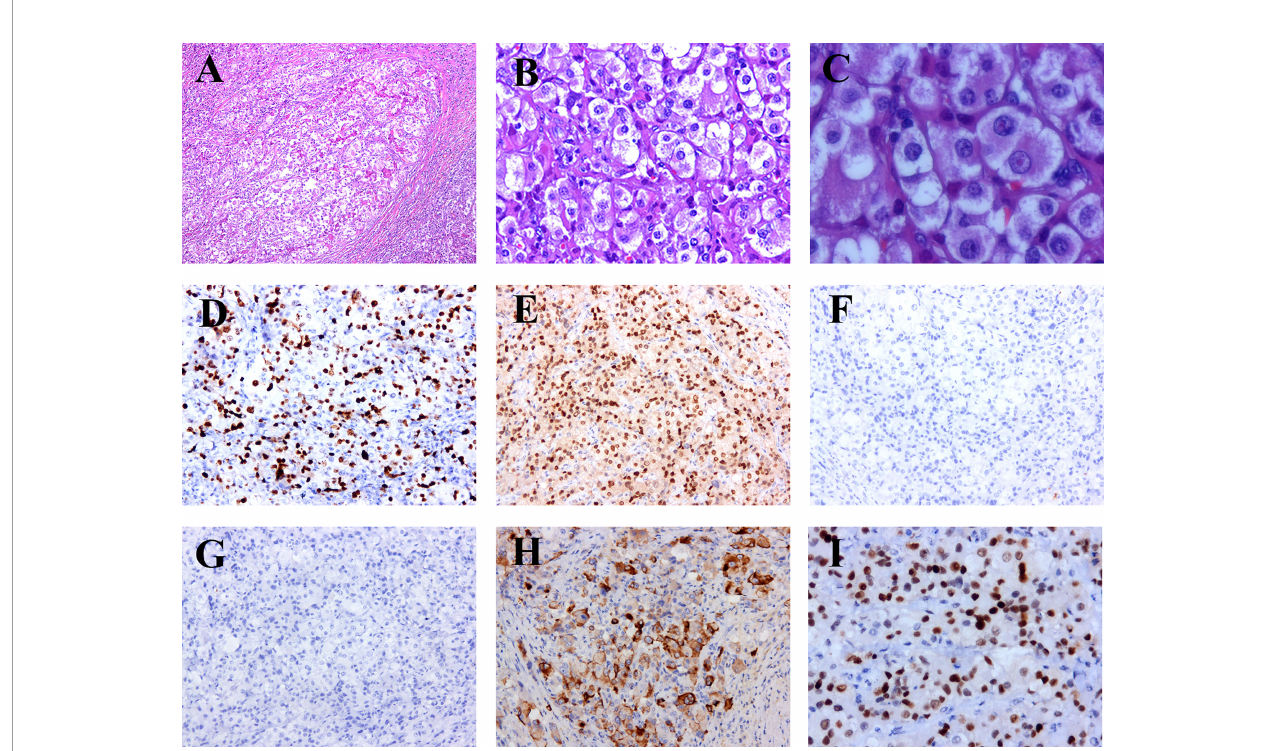
FIGURE 2 | Hisopathological and immunohistochemical examinations. (A) 100 times. Dense eosinophilic cytoplasm, with red staining and large obvious nucleous. (B) 200 times. Large cell with abundant eosinophilic cytoplasm and a large hyperchromatic nucleus with a prominent nucleolus, obvious nuclear heteromorphism, and visible mitotic strutures. (C) 400 times. (D) The positive rate of Ki67 is 70%. (E) TTF-I positive. (F) CK19 negative. (G) TG negative. (H) PCK focal positive. (I) P53 part